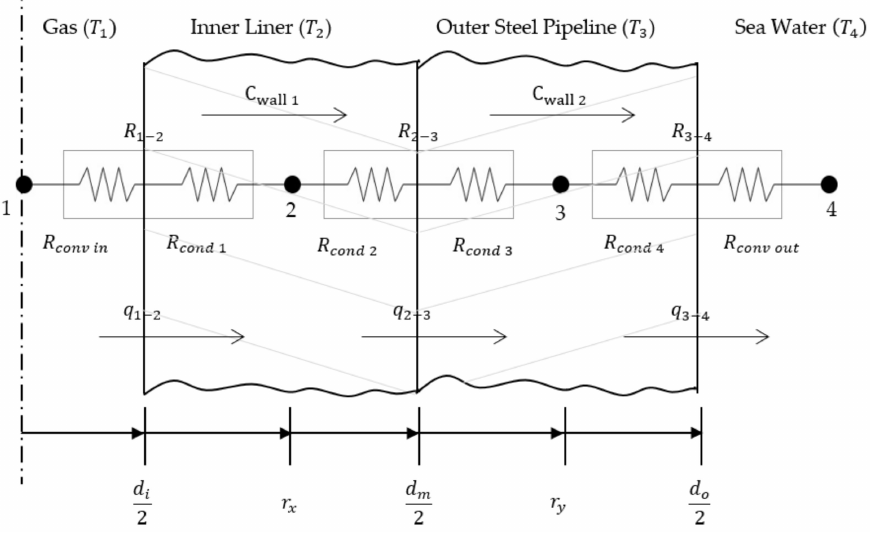
Figure 3. Resistances and capacitance model of the accumulator